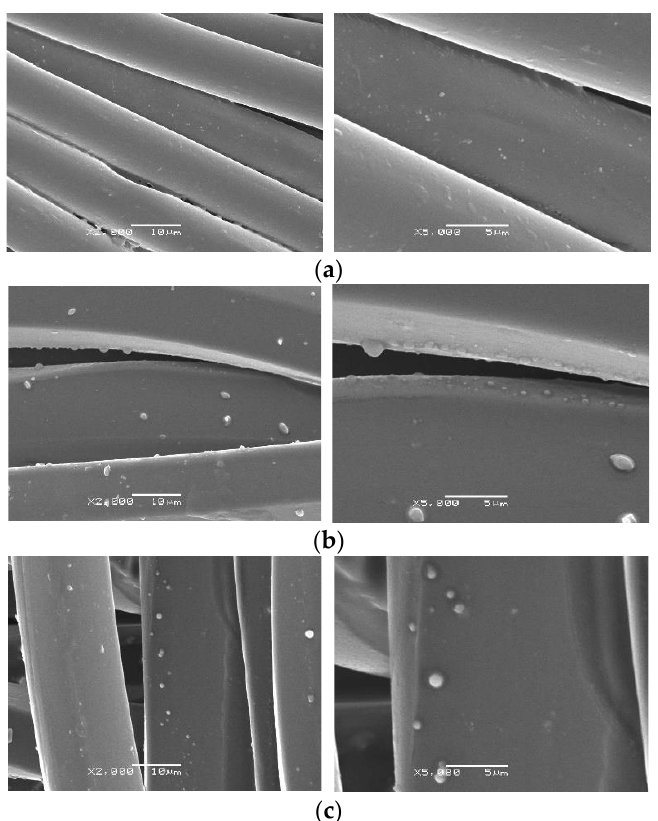
Figure 2. Morphology of polyester-impregnated samples: ( a ) untreated polyester, ( b ) polyester treated with plasma, ( c ) polyester treated with ozone. Magnification of 2000 and 5000x.